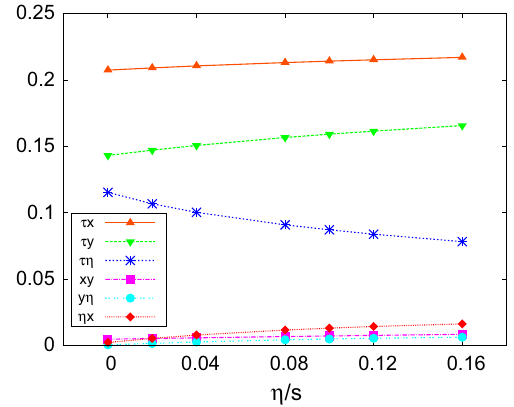
Fig. 11 Mean of the absolute value of thermal vorticity covariant components at the freeze-out as a function of η/ s . Note that the (cid:6) ,(cid:6) ,(cid:6) τη have been multiplied by 1 /τ x η y η